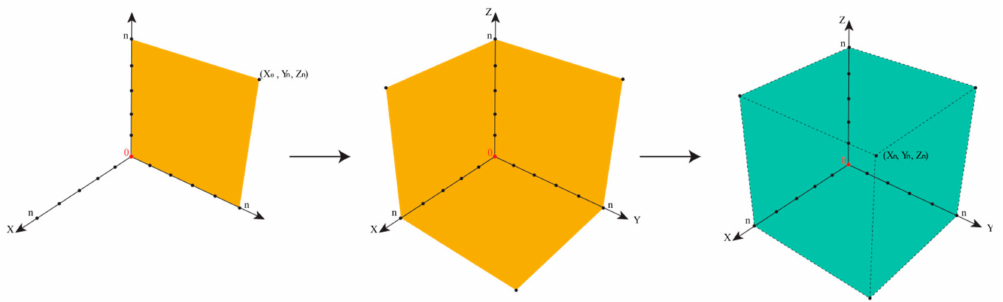
Figure 7. Illustration of NDMA impurity in Valsartan (see text for